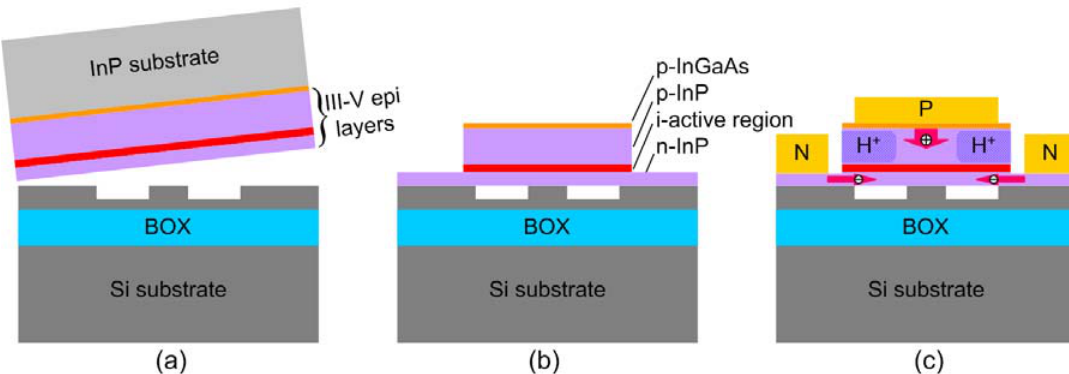
Figure 10. A simplified fabrication process to form the hybrid Si device platform. (a) Bonding of the III-V wafer to the patterned SOI wafer. (b) InP substrate removal and mesa etching. (c) Current confinement and metal contact